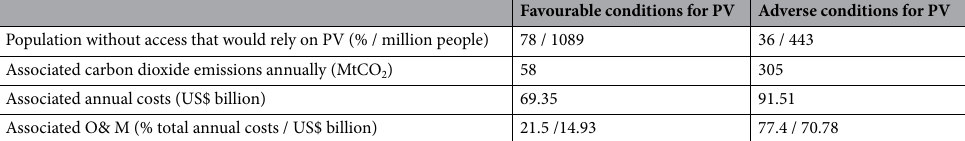
Favourable conditions for PV Adverse conditions for PV